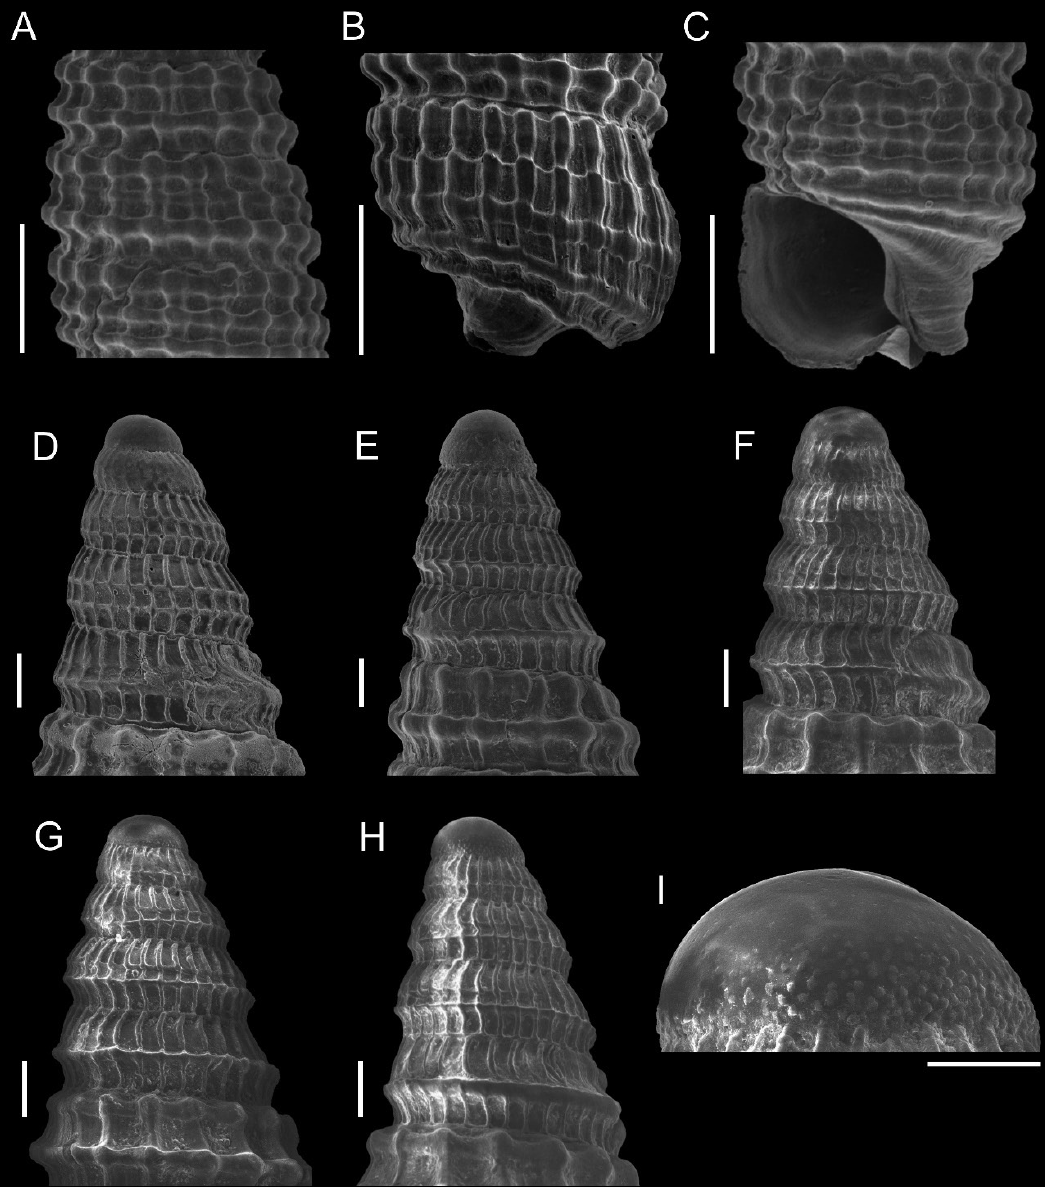
Fig. 8. Marshallora ostenta Rolán & Fernández-Garcés, 2008 from Brazil. A–C, E . IBUFRJ 19532, same shell as Fig. 7N. D . MNRJ 18623*. F . MNRJ 31017*, same shell as Fig. 7K. G . MNRJ 33801*, same shell as Fig. 7F. H–I . MNRJ 30750*, same shell as Fig. 7J. Scale bars: A–C = 500 µm; D–H = 100 µm; I = 50